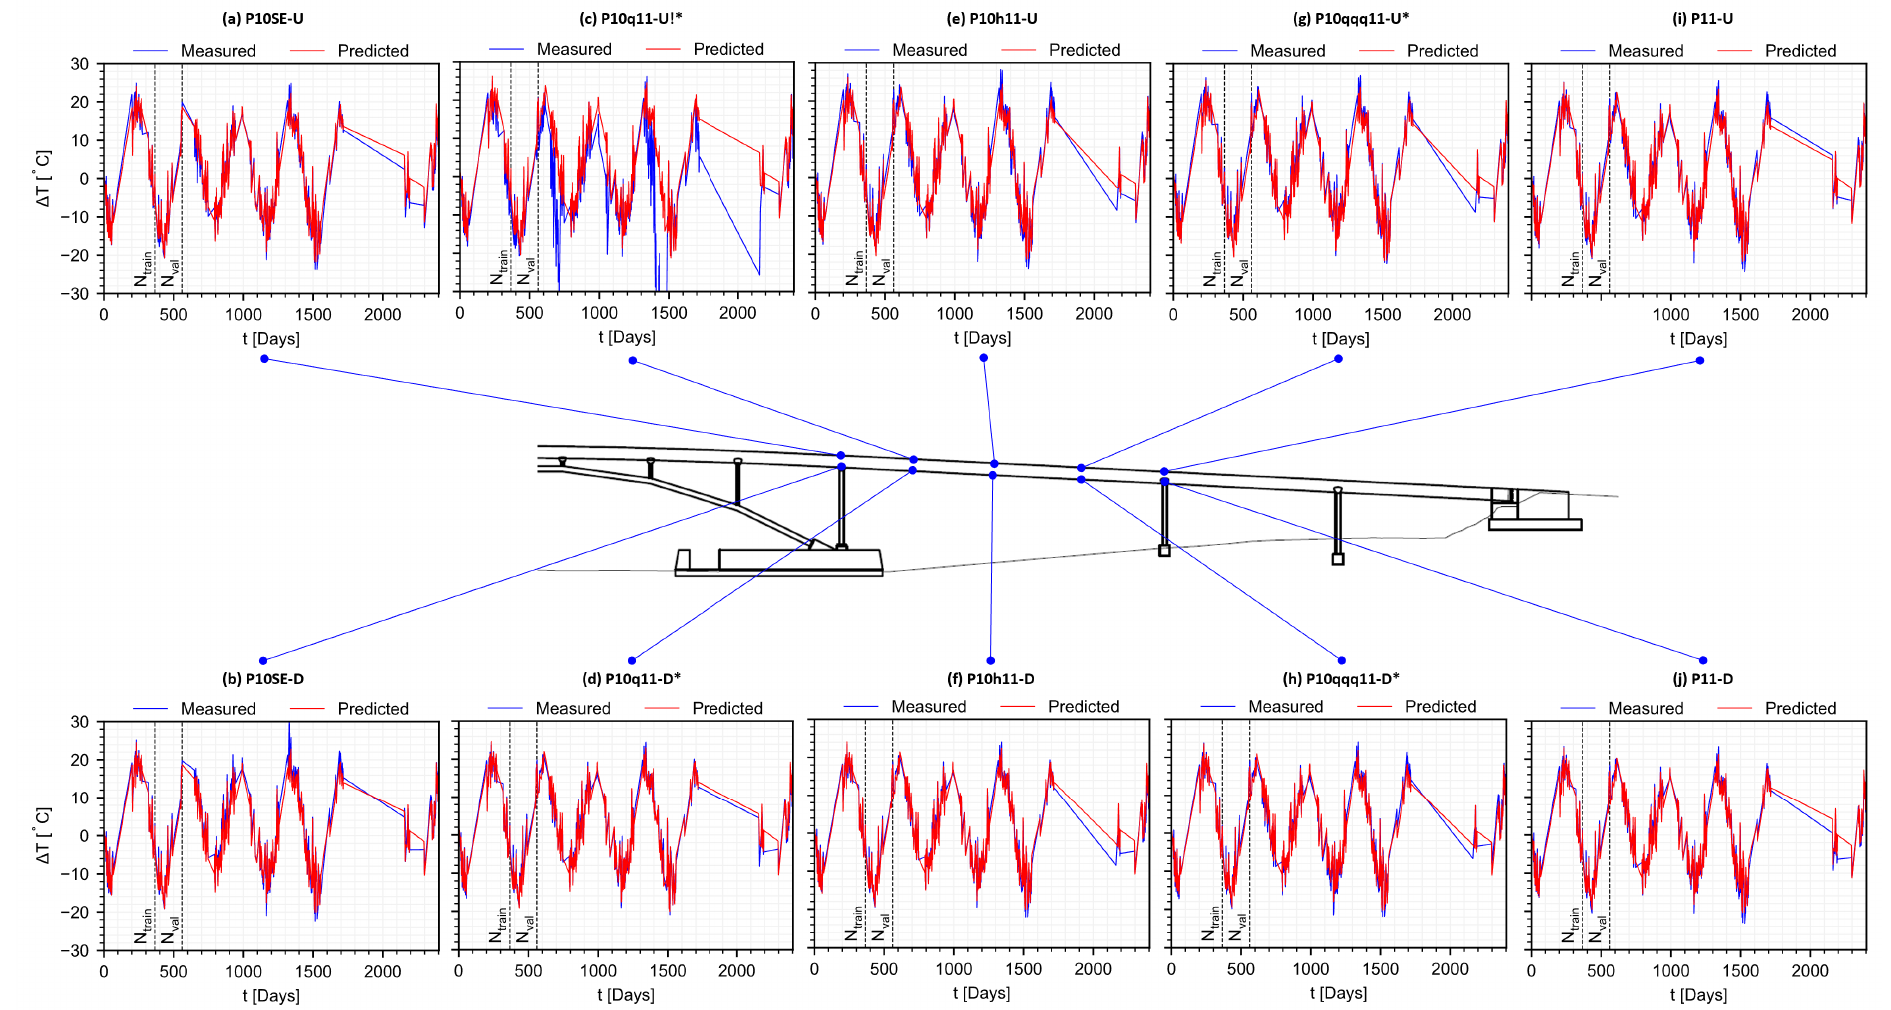
Figure 8. Predicted temperature at instrumented positions. Exclamation indicates positions with data anomaly. Asterisk indicates positions not observed during training or